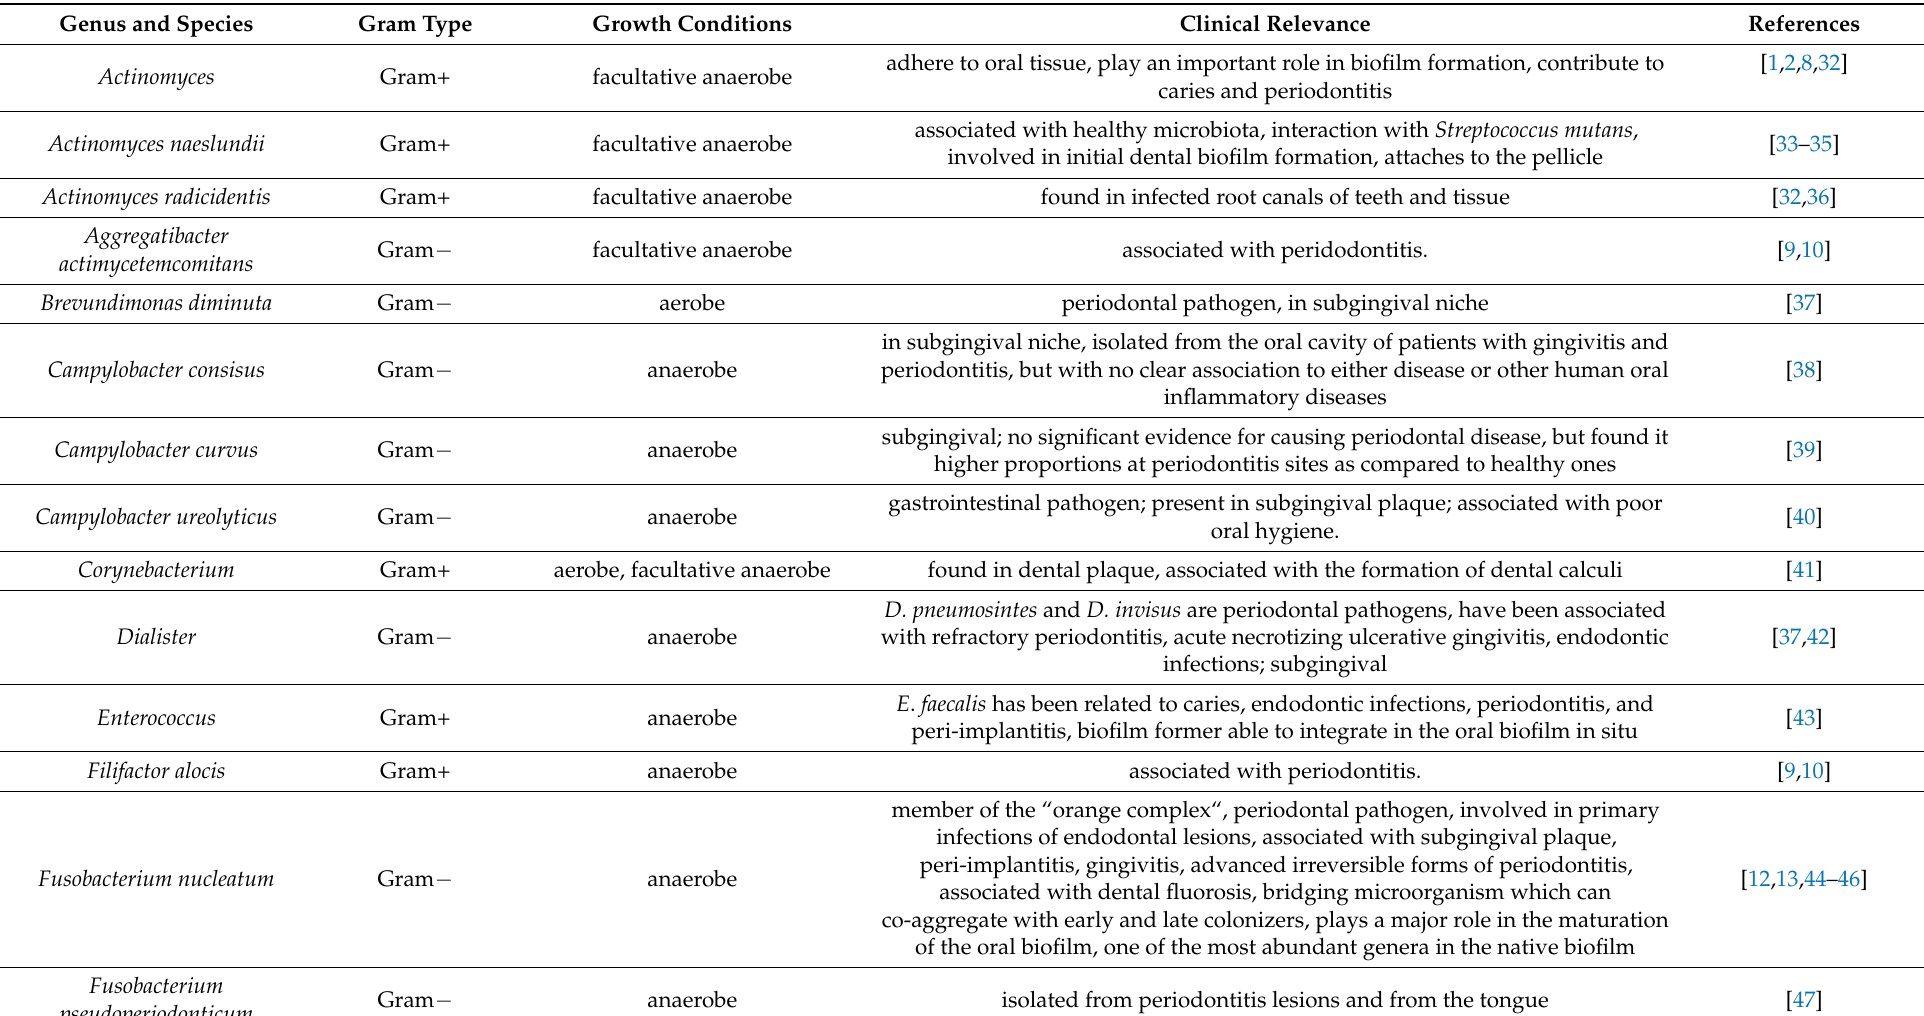
Table 1. Important bacterial genera and species found in the human oral cavity, and their association with oral health or